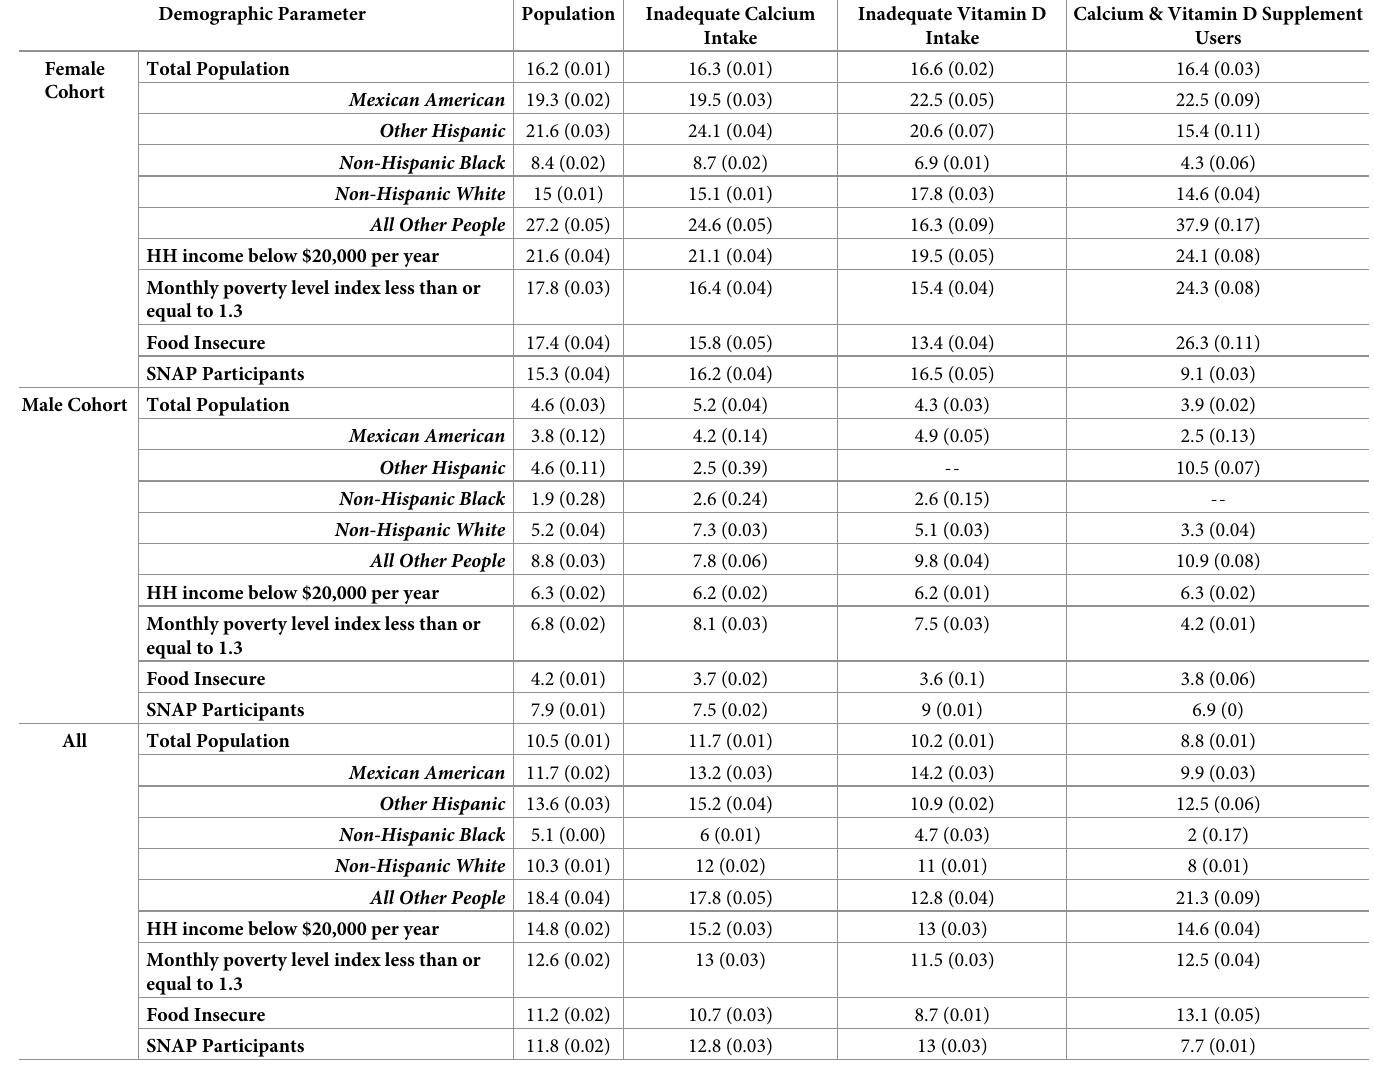
Table 2. Risk of osteoporosis, United States, by major population cohorts, %, age 50 and older.